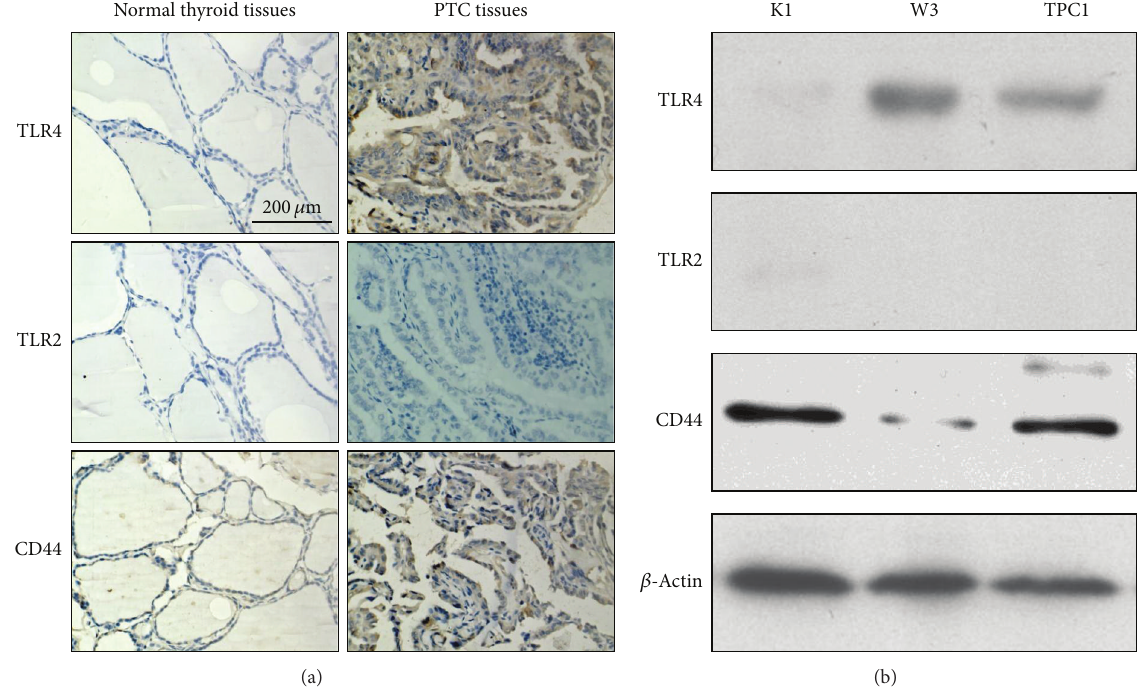
Figure 1: Increased TLR4 expression in PTC tissues and cell line W3. (a) Representative examples of IHC staining analyses of TLR4, TLR2, and CD44 in human normal thyroid tissues and PTC tissues (original magnification 400 × ). (b) Immunoblot analysis of the expression of TLR4, TLR2, and CD44 on 3 human PTC cell lines. Representative results are